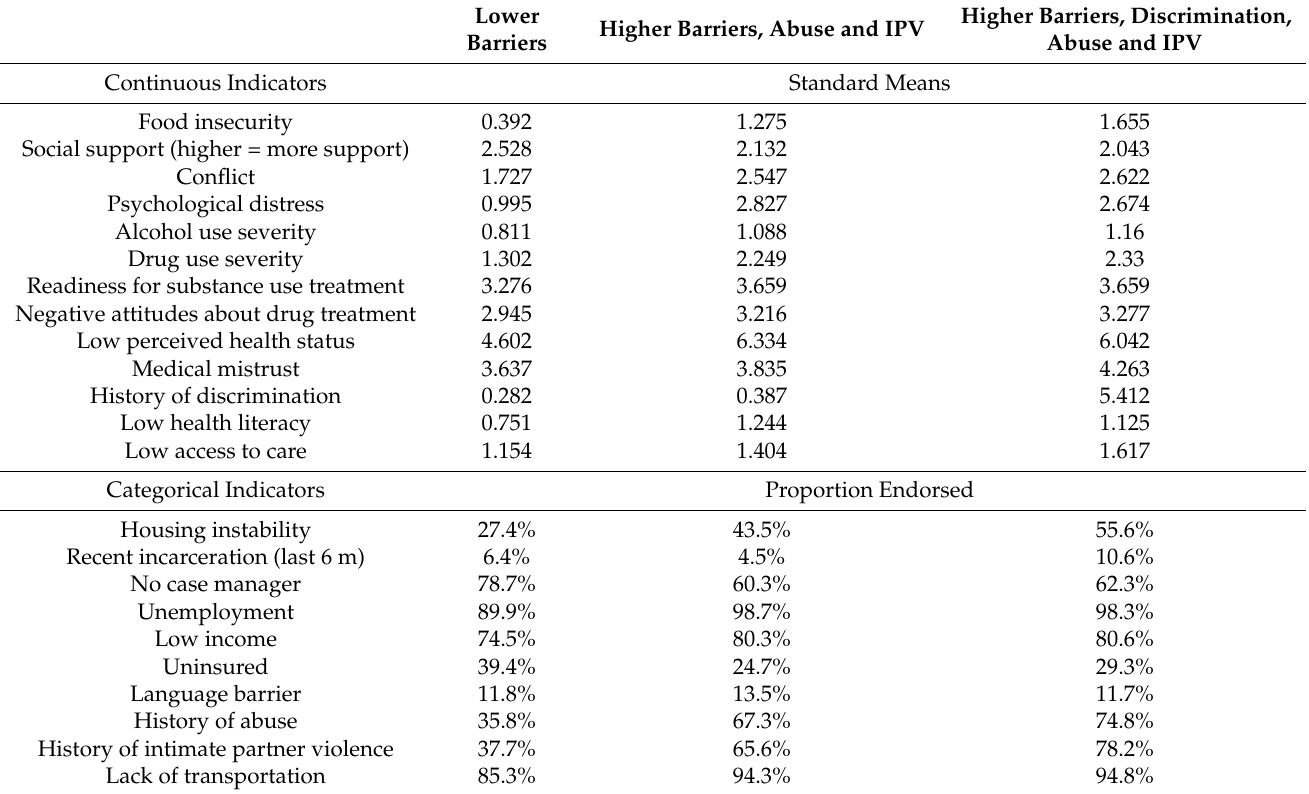
Table 4. Standard means and proportions of continuous and categorical indicators by